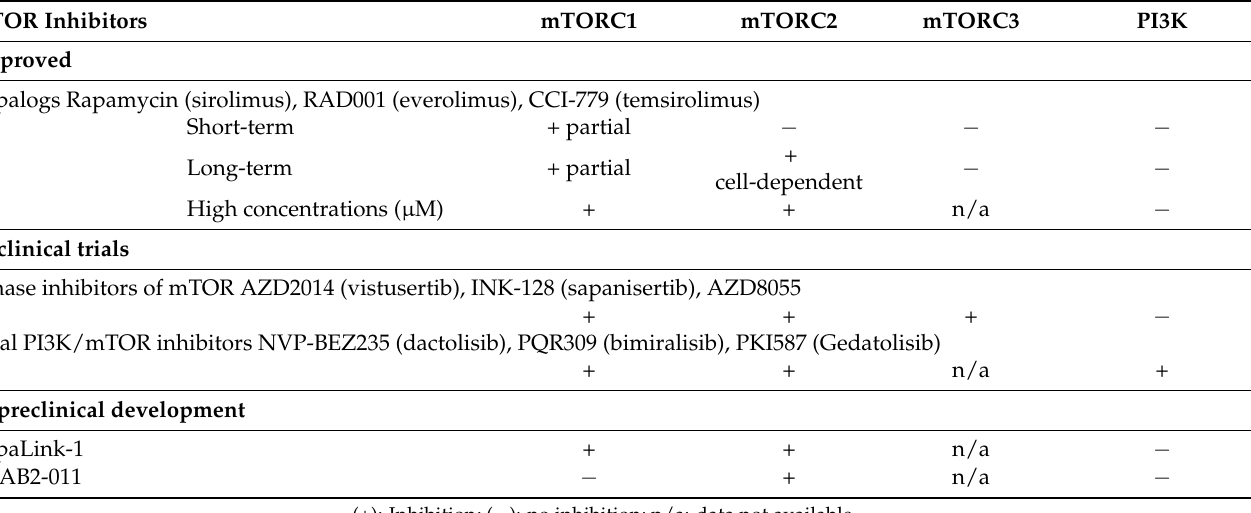
Table 1. mTOR inhibitors and their effects on mTOR